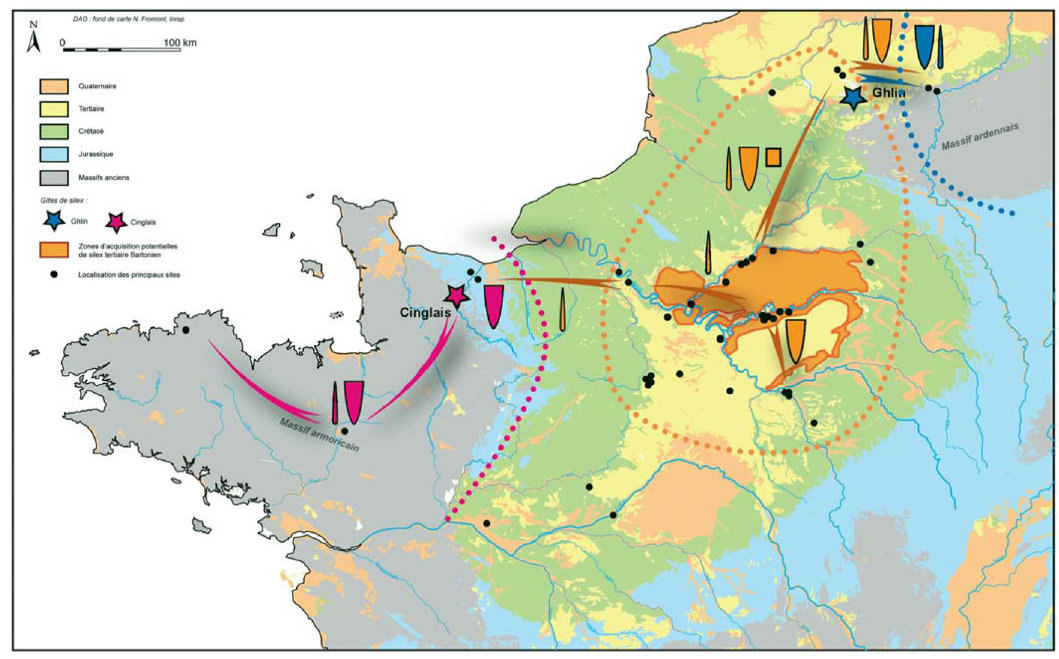
Figure 8: Schematic representation of fl int supply sources and territories in the Paris Basin and its margins during the middle stage of the BVSG culture, with indication of the circulation of nucleus ( conic form ) or blades ( elongated form ) ( after Bostyn et al., 2019, Figure 5 )